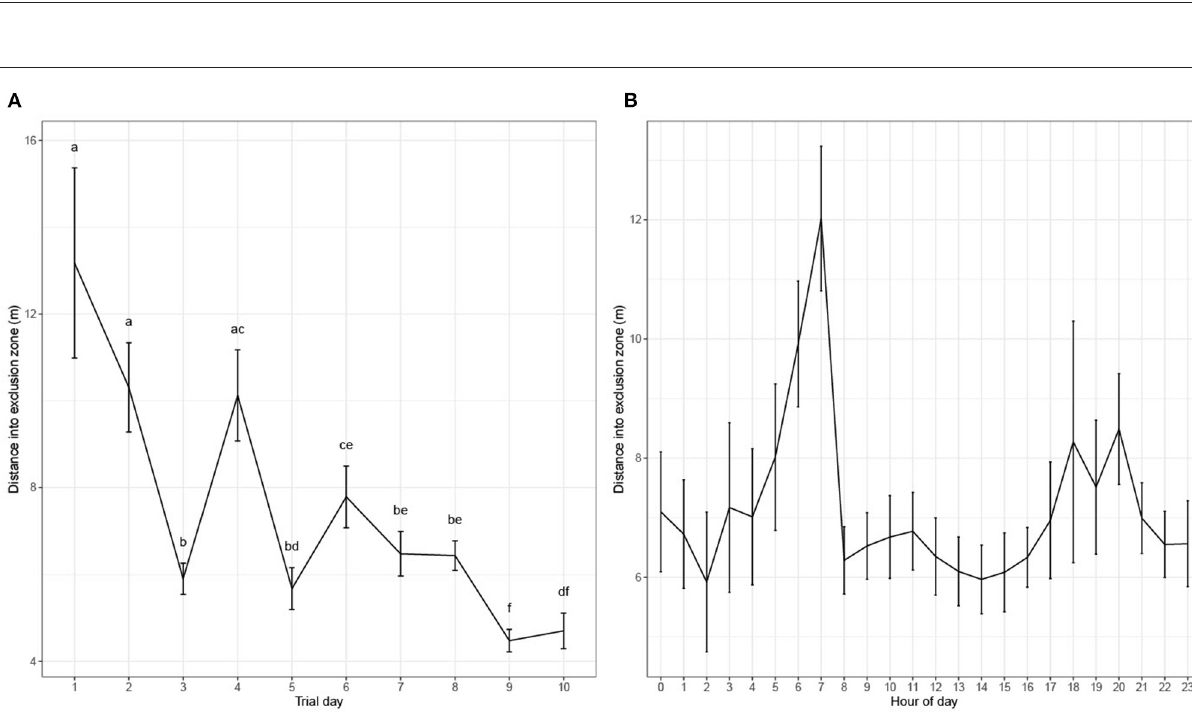
Frontiers in Animal Science |